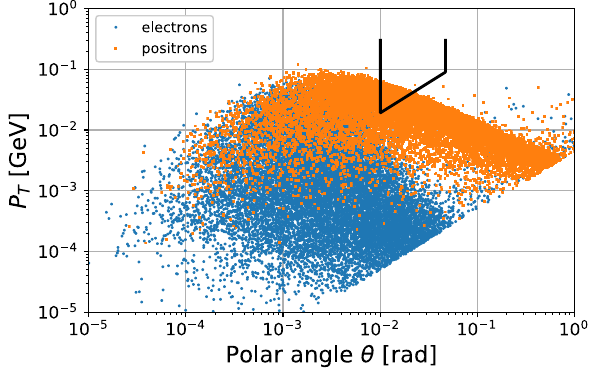
FIG. 6. An example of a sextupole linear knob scan. We plot the luminosity signal together with the incoherent pairs signal. A single parabolic fit provides a robust method of finding the optimum, provided that we scan over a sufficient range and use a large number of